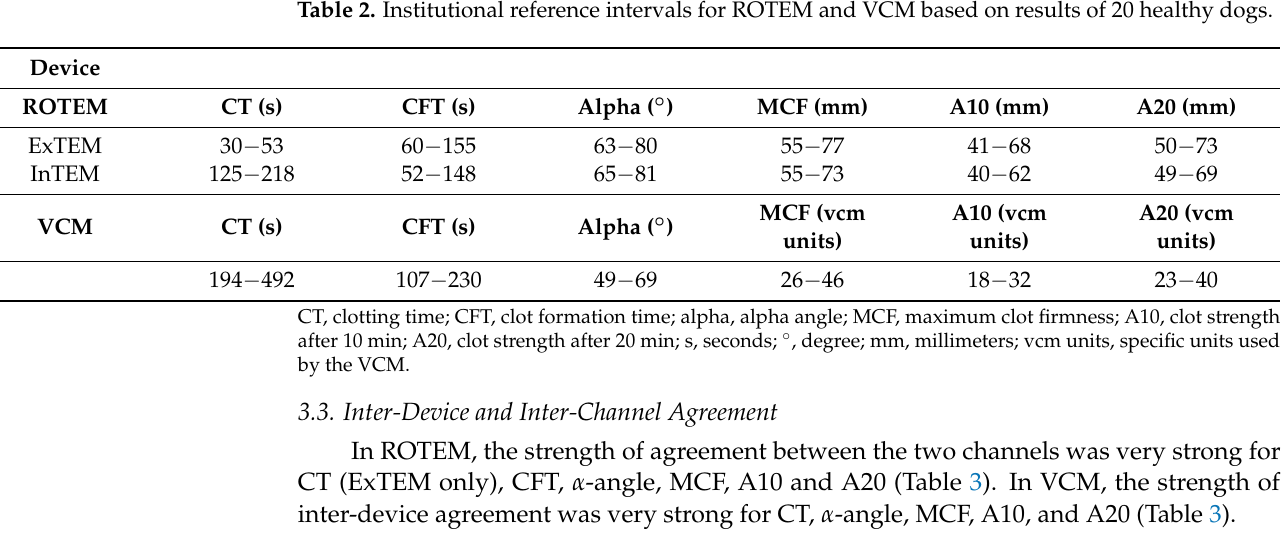
Table 3. Inter-device (VCM) and inter-channel (ROTEM InTEM and ExTEM) agreement in blood samples of 60 dogs (20 healthy dogs and 40 diseased